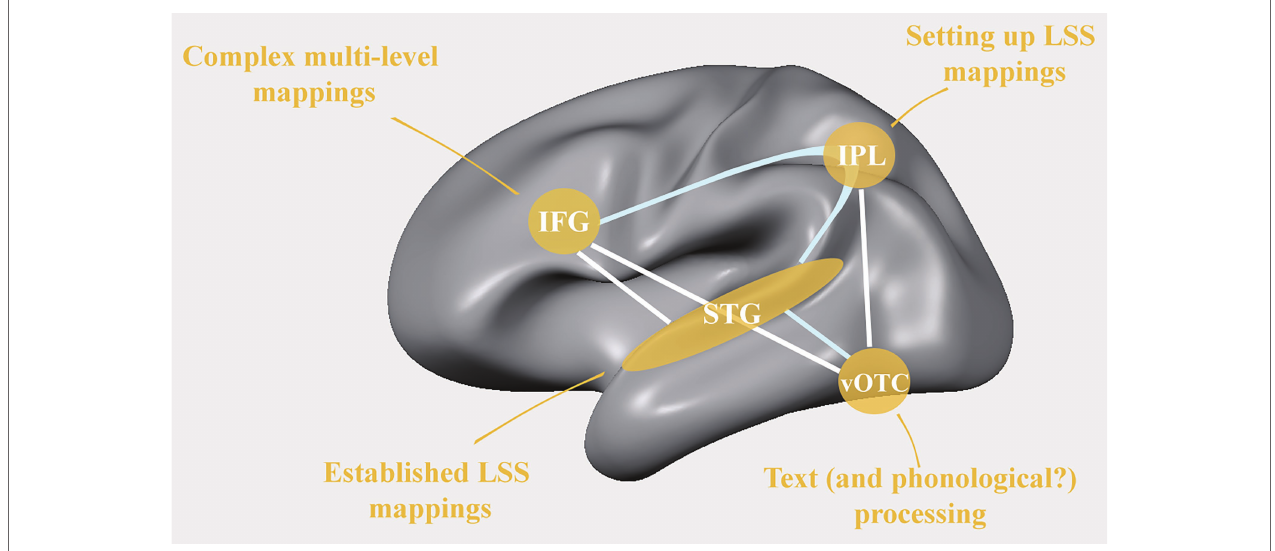
FIGURE 2 | Areas where reduced cortical activation has been reported in readers with dyslexia alongside frequently observed differences in functional (white lines) and structural (light blue lines) connectivity between readers with and without dyslexia. IFG: inferior frontal gyrus; IPL: inferior parietal lobe; STG: superior temporal gyrus; vOTC: ventral occipito-temporal cortex; LSS: letter-speech